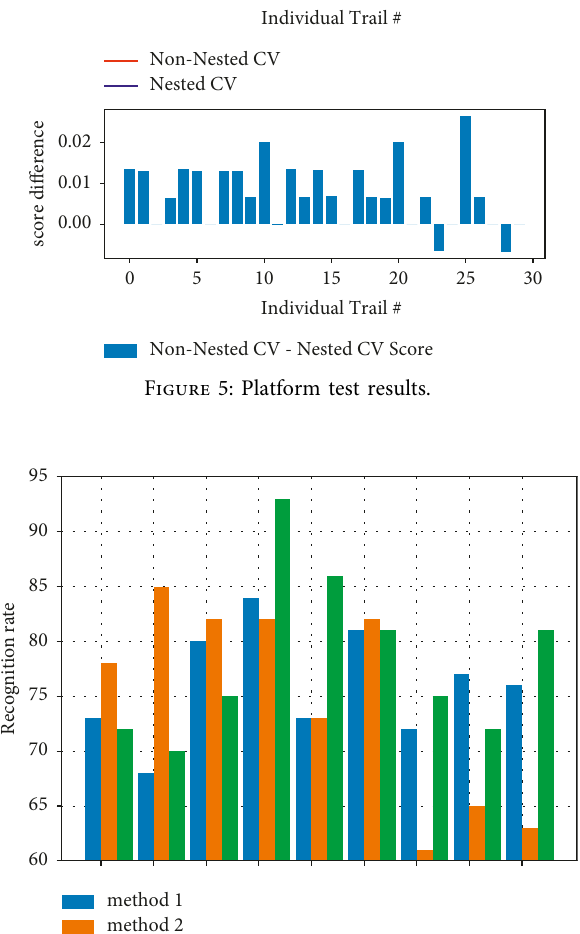
Figure 6: Recognition rate of different network